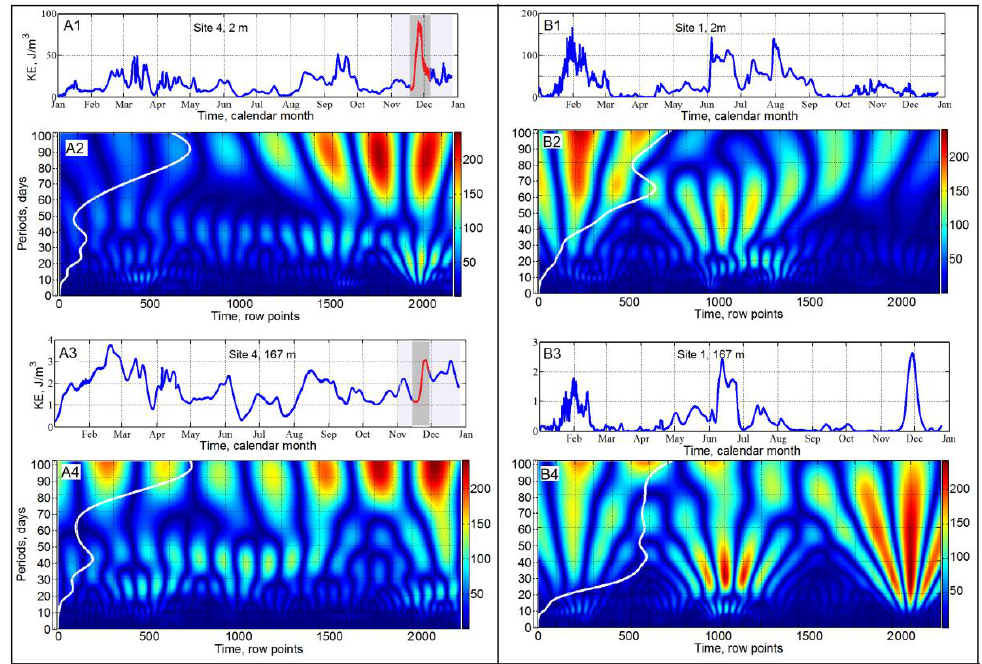
Figure 4. Temporal variations of the kinetic energy density (KE) and the wavelet density (WD) of KE in the range of periods 1–100 days during the model year 39 at Sites 4 (left panel) and 1 (right panel). KE and WD are presented at two depths: 2 m ( A1 , A2 , B1 , B2 ) and 167 m ( A3 , A4 , B3 , B4 ). The white curve shows the time-integrated WD spectra integrated over time. At the right side of each wavelet diagram, the color scale indicates the intensity of the square of the KE. The right color scale denotes units of WD (J/m 3 ); the 4-day series of KE and WD output corresponds to monthly/row points at the lower scales of KE and WD. The red lines in the shaded parts of the panels A1 and A3 indicate the appearance (at the row points around 2000) of a coherent eddy spanning the depths from the surface to at least to 167 m.